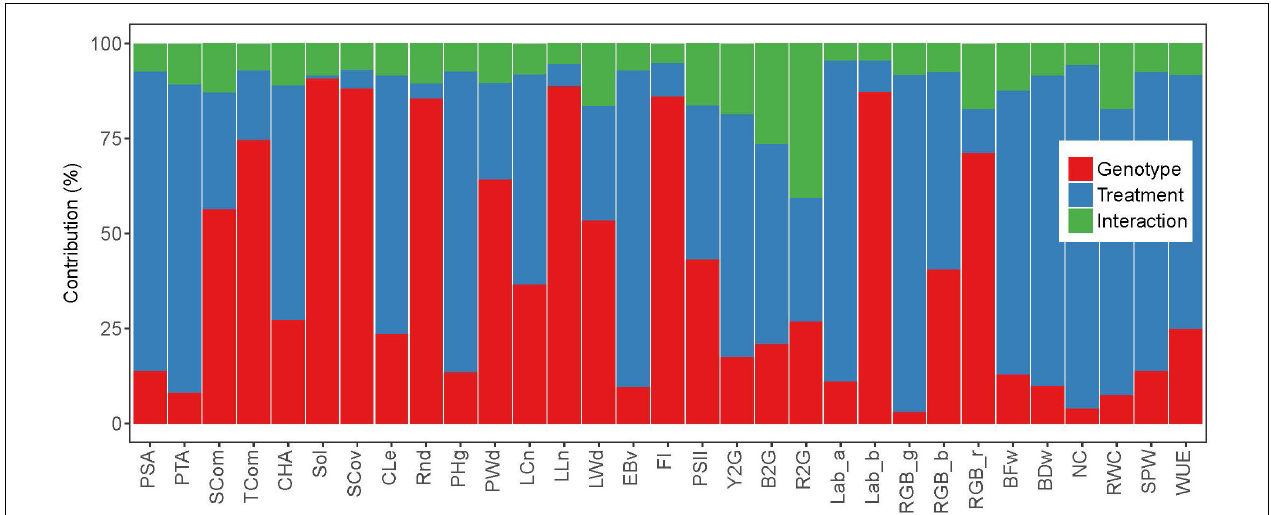
FIGURE 1 | Relative contribution of the variance components (estimated by REML model) to the phenotypic variance of image-based and manually measured traits.